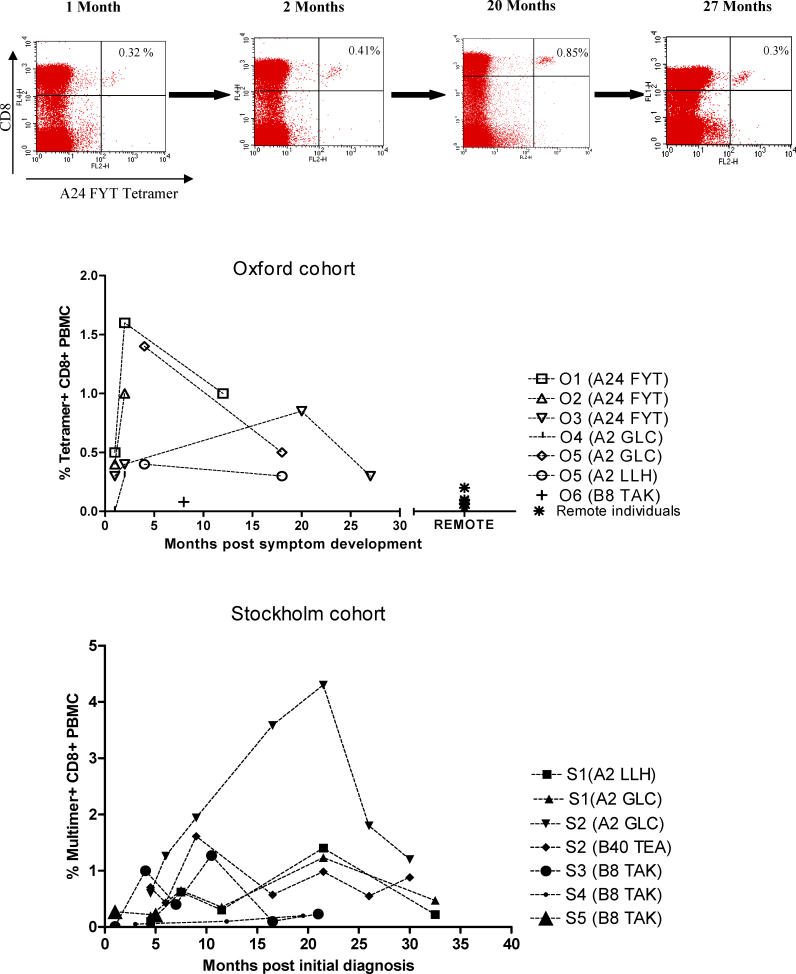
B19-Specific CD8+ T Cells Persist at High Levels for Many Months after Acute Infection(A) Representative A24 FYT tetramer staining of individual O3\′s PBMCs. Plots are gated on live CD8+ lymphocytes stained directly ex vivo. Percentages shown are those of tetramer-positive CD8+ T cells. Time points indicated refer to the number of months after first symptoms reported. Symptoms in this individual lasted 5 wk.(B) Frequency of B19-specific responses over time for six acutely infected individuals in the Oxford cohort (O1–O5) and five remotely infected individuals (OR1–OR5). In one case, two epitopes were studied.(C) Frequency of B19-specific responses over time for five acutely infected individuals in the Stockholm cohort (S1–S5). In two cases, two epitopes were studied.